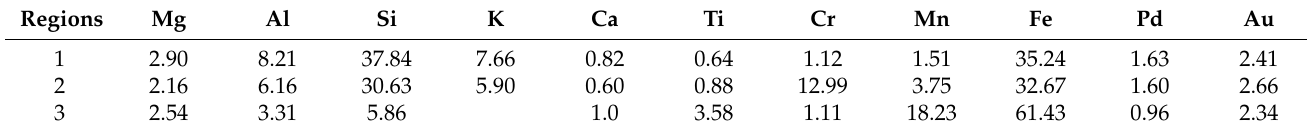
Table 1. Normalized mass concentration (The value is the percentage of